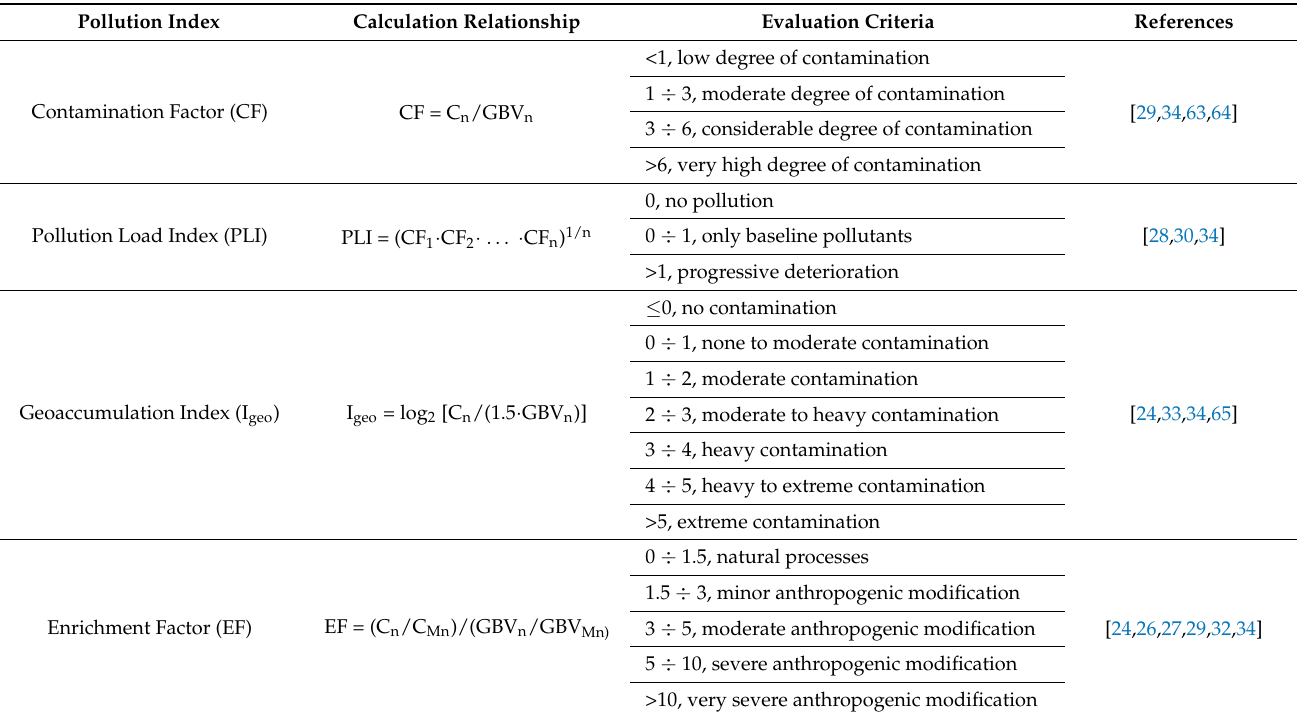
Table 1. Pollution indices and evaluation criteria used for the potential contamination of sediment